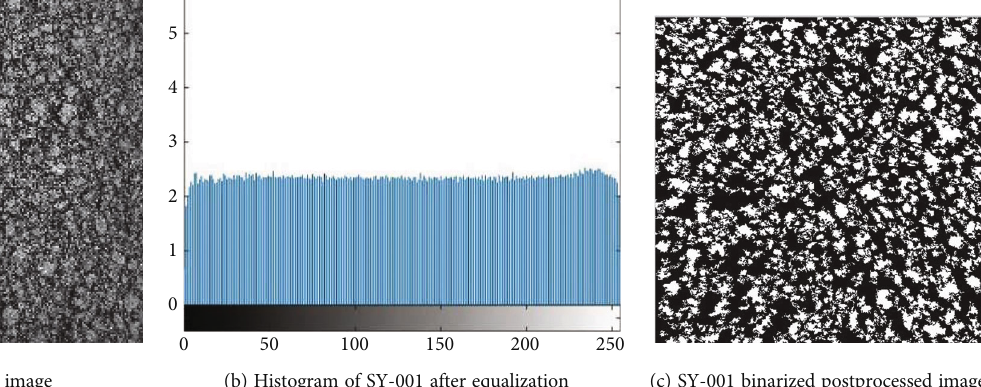
Figure 3: Image processing.